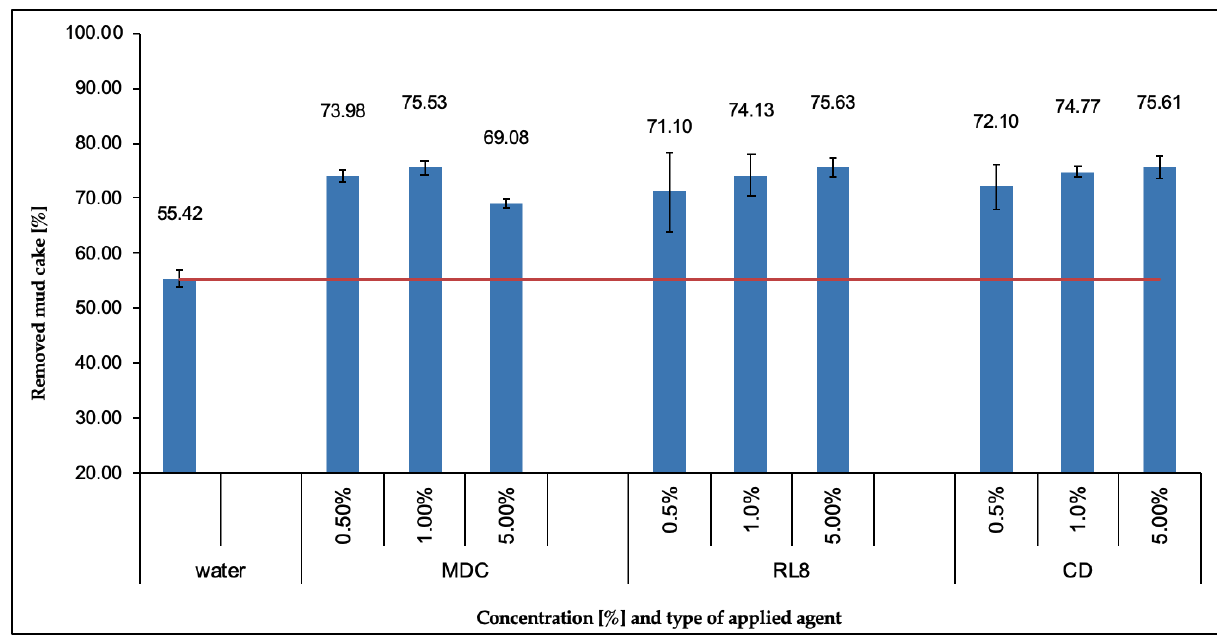
Figure 5. Efficiency of mud cake removal from the rotor’s surface with traditional agents. The red line shows the reference value for water.